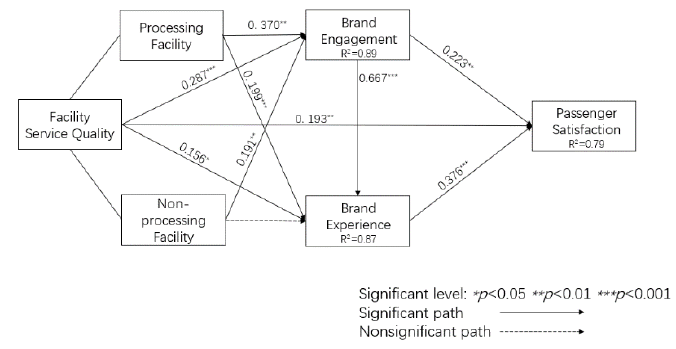
Figure 2. The model of this